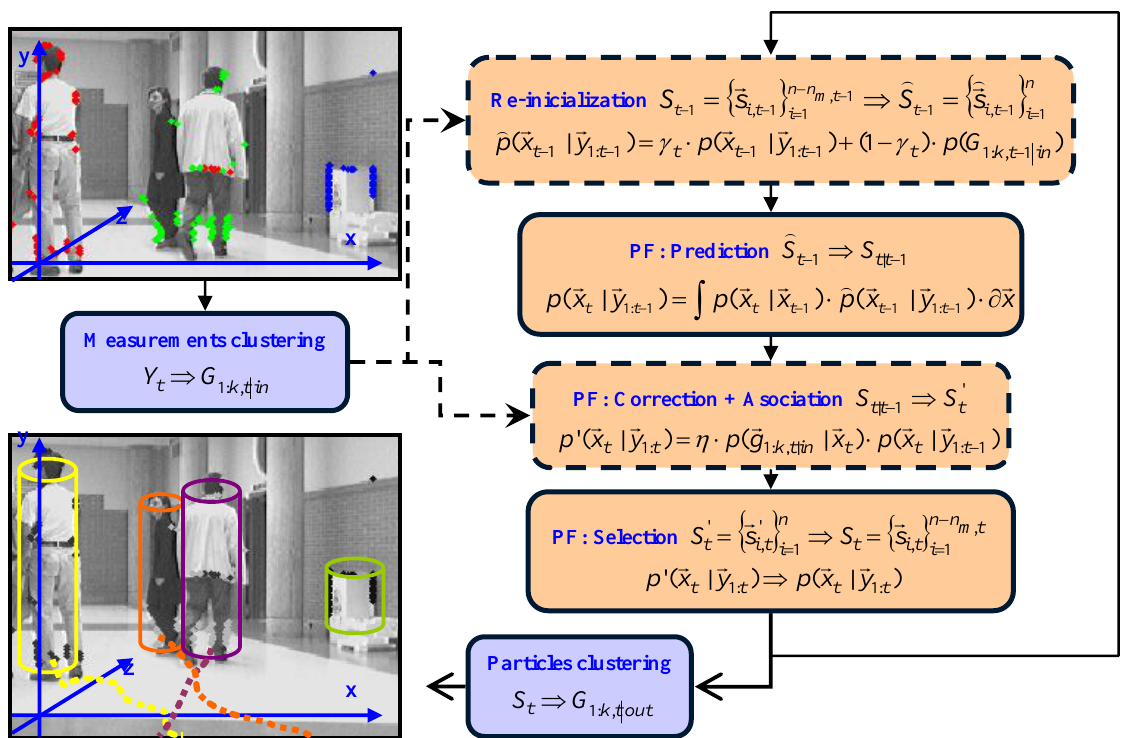
Figure 7. Functional diagram of the multiple objects’ tracker based on a XPFCP. Deterministic tasks have a blue background while probabilistic tasks have a different color. Modified or new PF steps are remarked with dashed